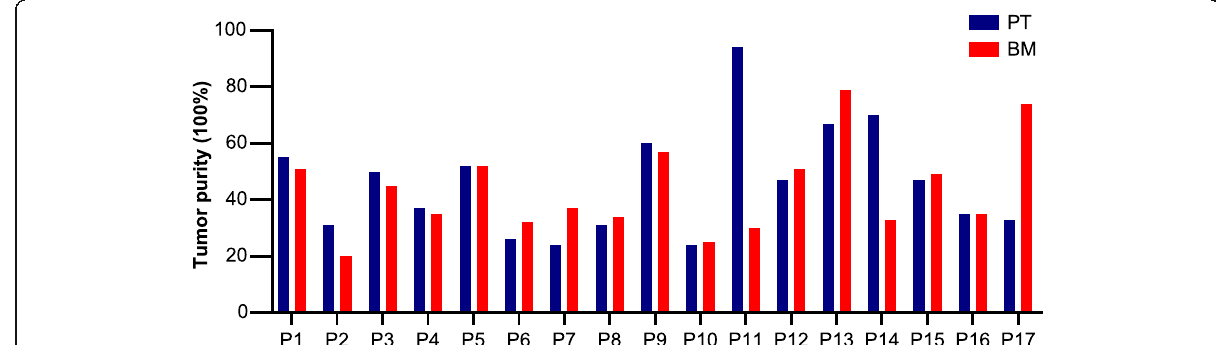
Fig. 2 Tumor purity by histology. Purity was defined as the ratio of tumor to normal